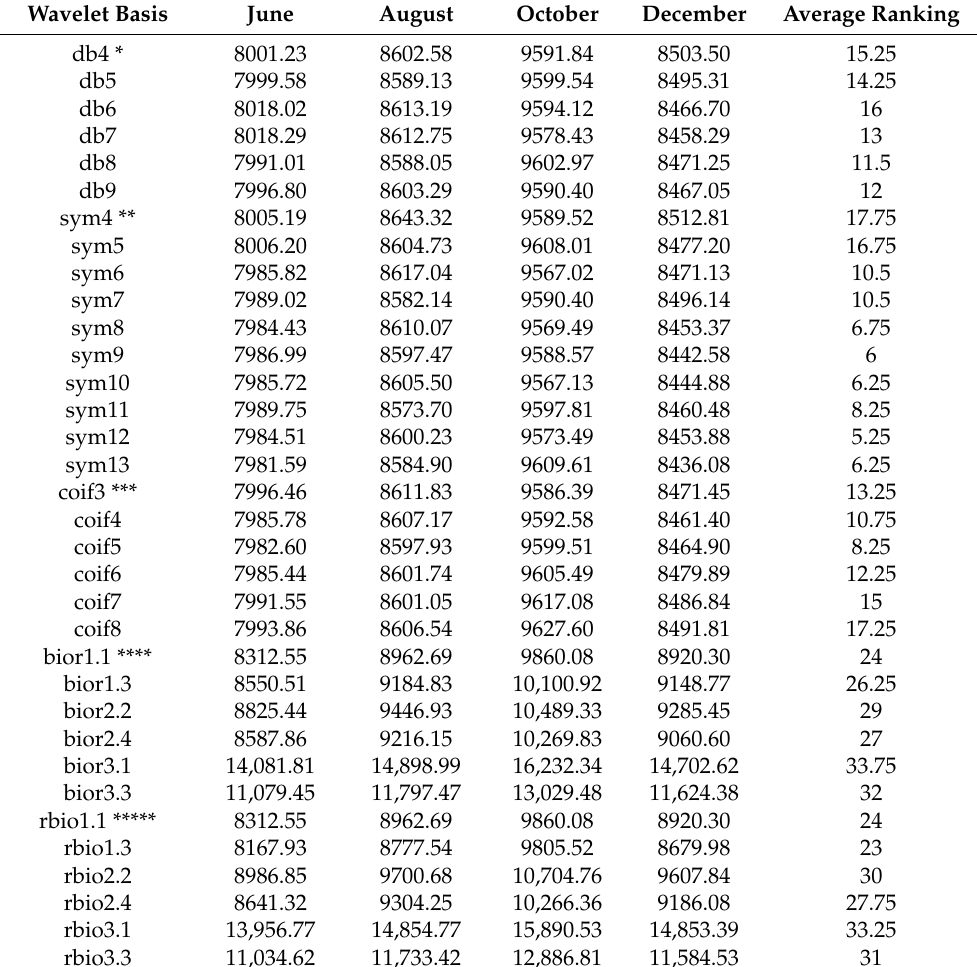
Table 3. SI values of wavelet basis in different